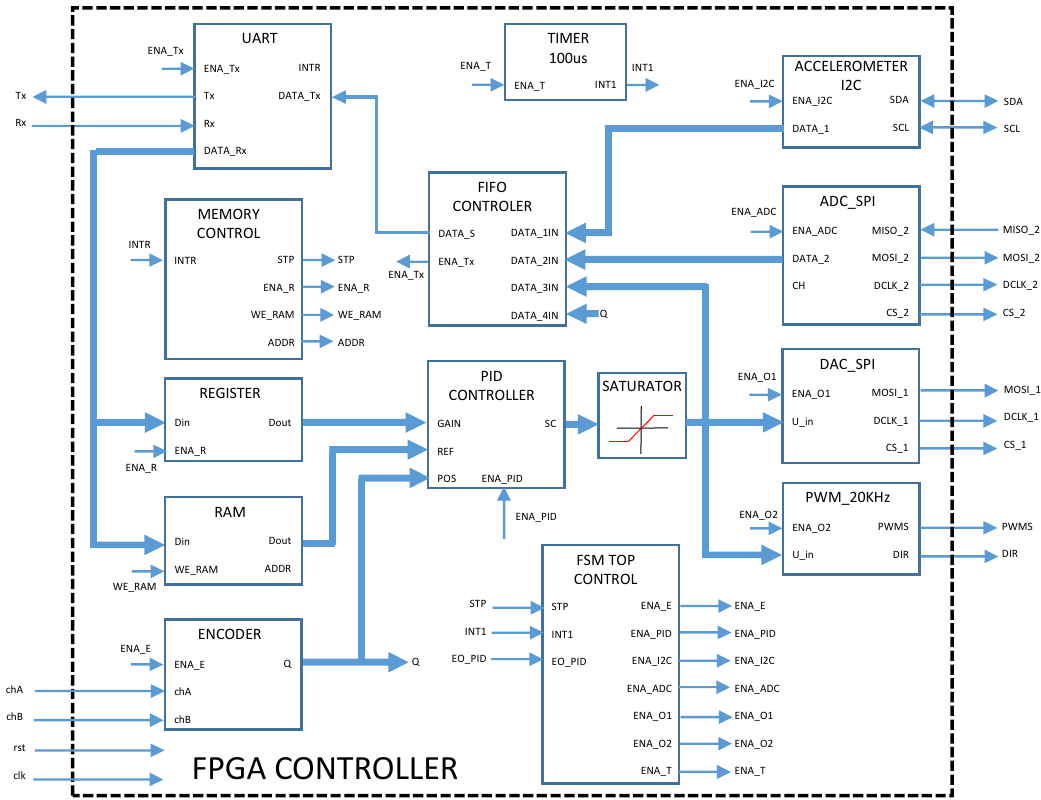
Figure 5. Modules implemented in the Field Programmable Gate Arrays